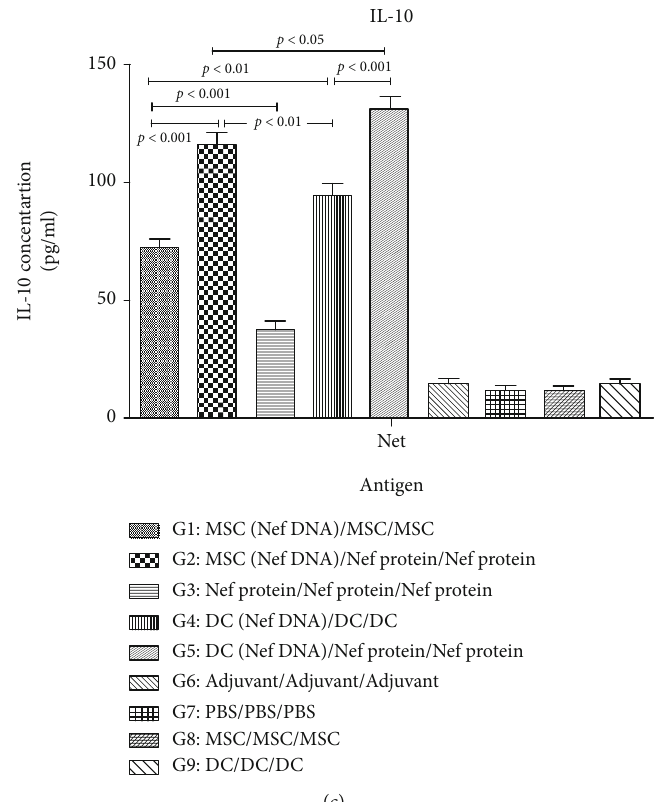
Figure 6: Secretion of IFN- γ , IL-5, and IL-10 in immunized groups with di ff erent formulations: the levels of IFN- γ (a), IL-5 (b), and IL-10 (c) were determined by ELISA as mean absorbance at 450 nm ± SD for each set of samples. All analyses were performed in duplicate for each sample.